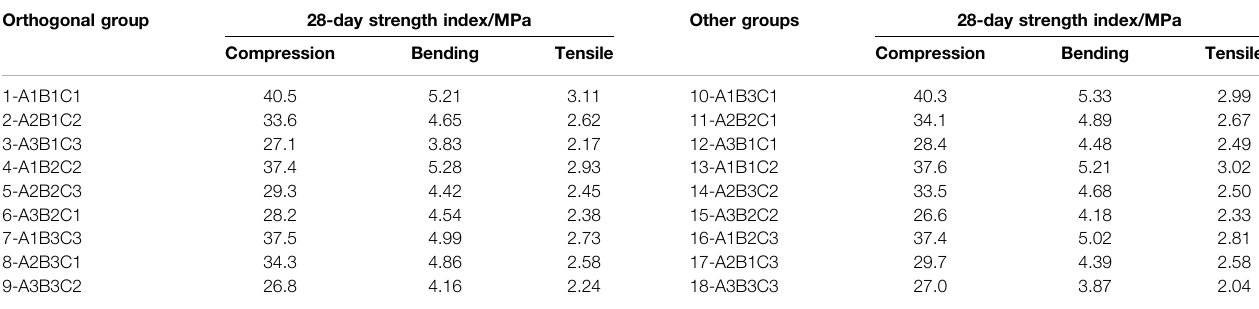
TABLE 6 | Testing strength of rubber fi ber reinforced concrete. Orthogonal